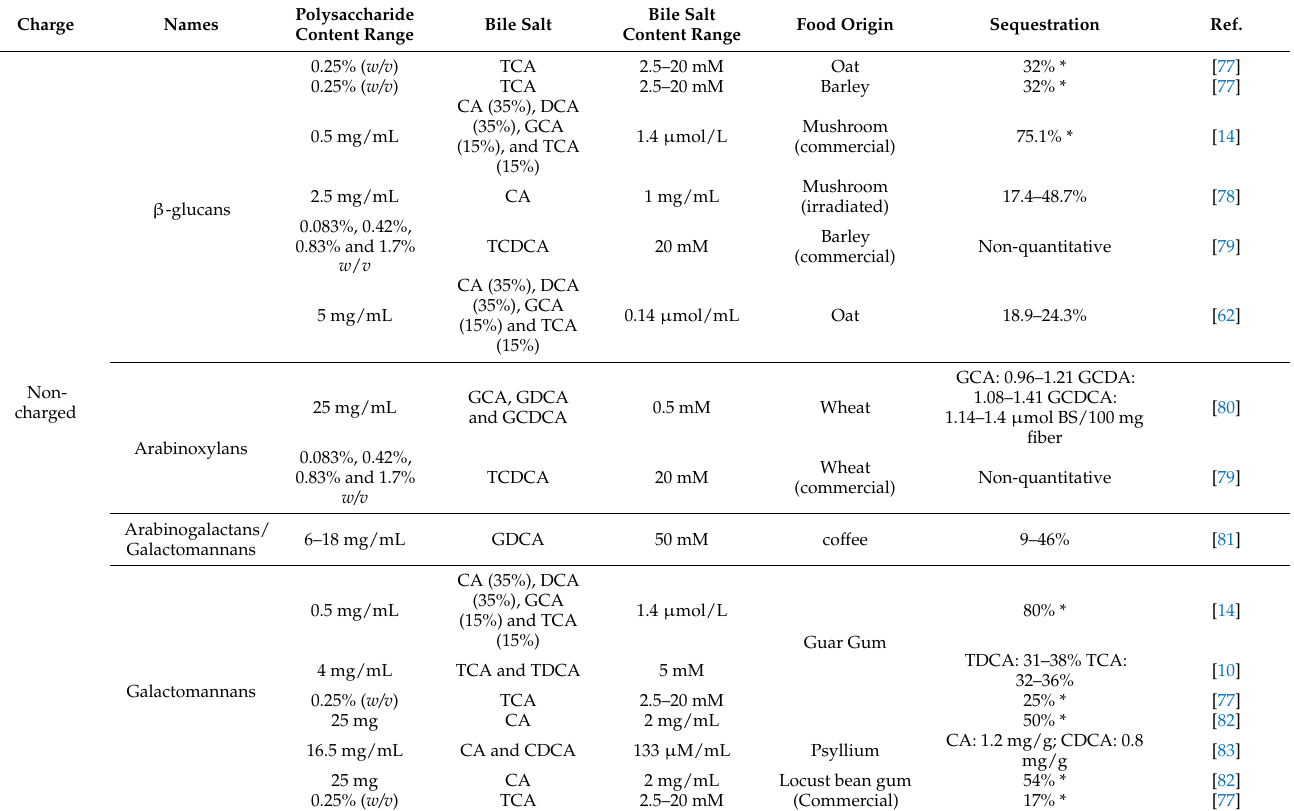
Table 2. Bile salt sequestration by polysaccharides of different food